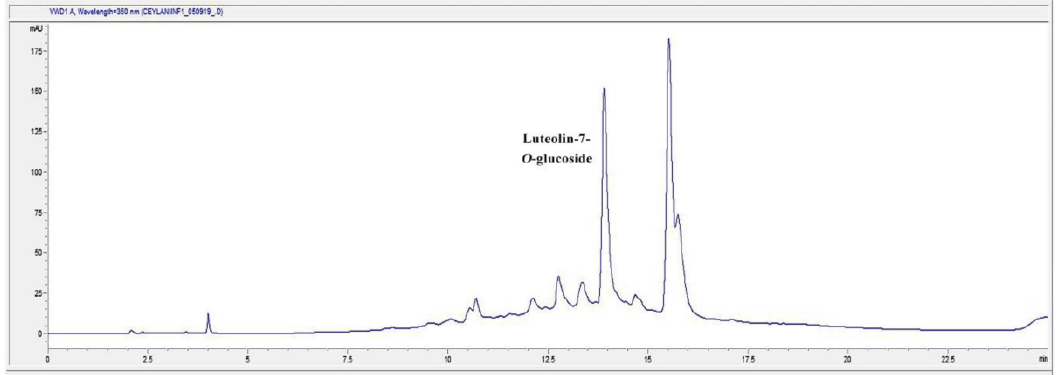
Figure 7. The HPLC Chromatogram of the infusion (I) extract of TS.